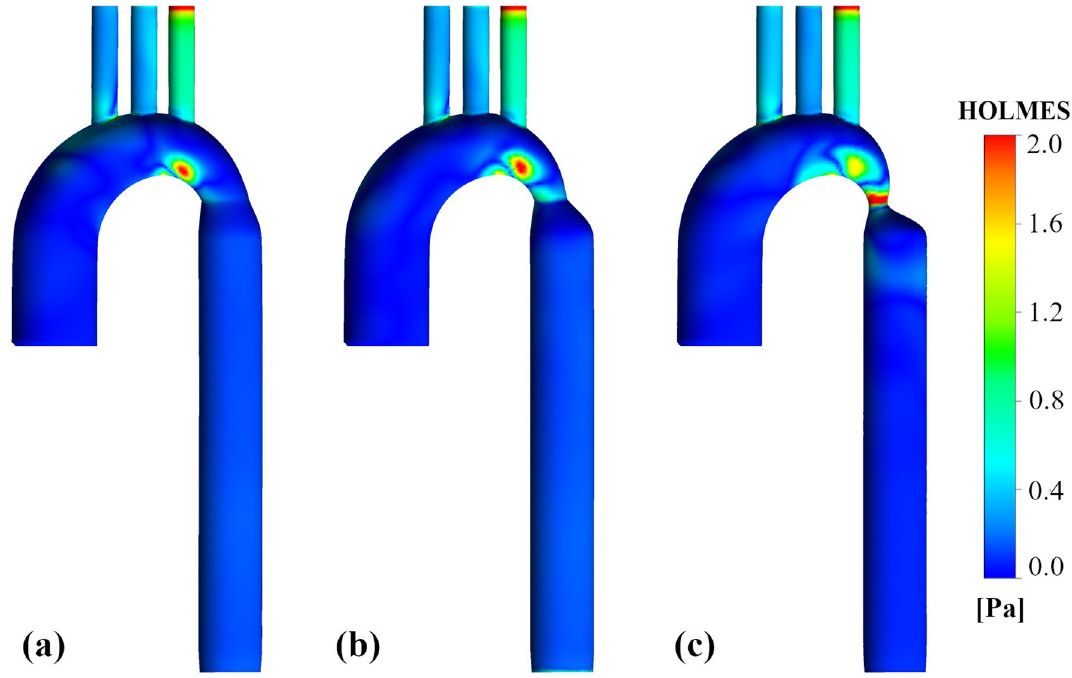
Figure 7. HOLMES characteristics. HOLMES distributions for the FSI simulation. ( a ) 25% coarctation ( b ) 50% coarctation ( c ) 75%